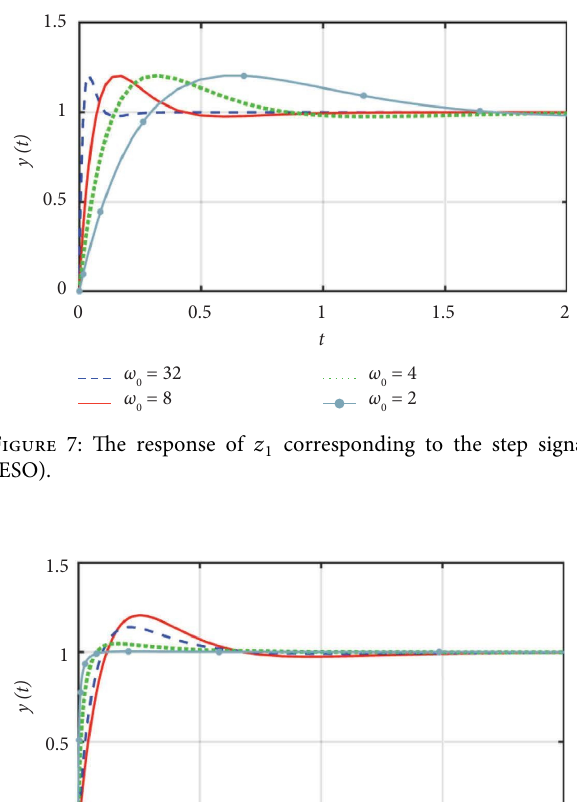
Figure 8: Te response of z (FOESO).